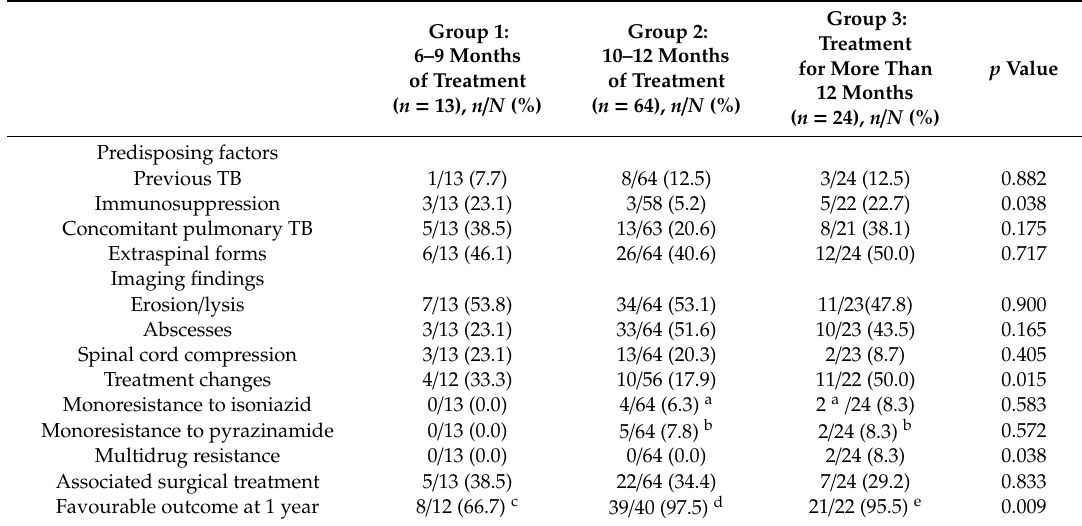
Table 4. Characteristics of 101 patients according to the duration of